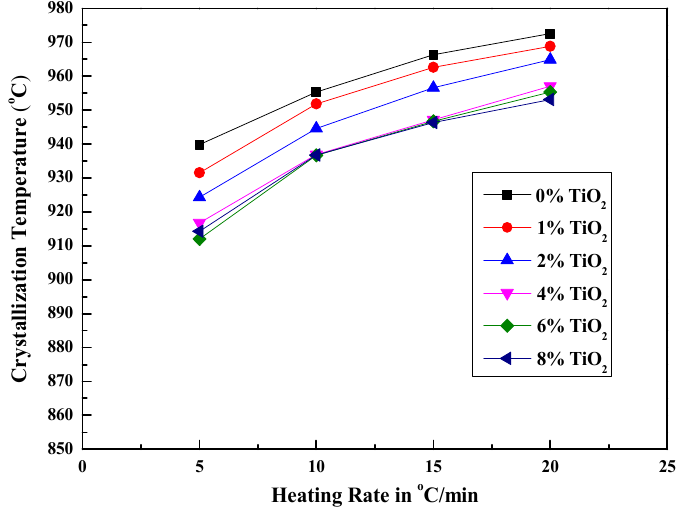
Figure 4. The Crystallization temperature of the samples with di ff erent heating